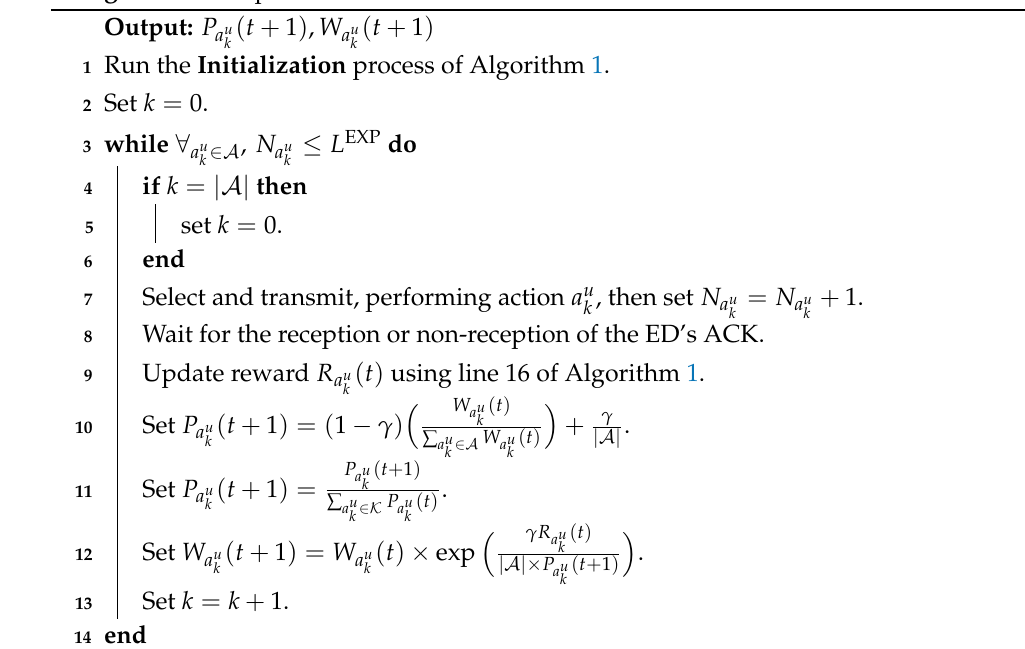
Algorithm 2: Exploration Phase of